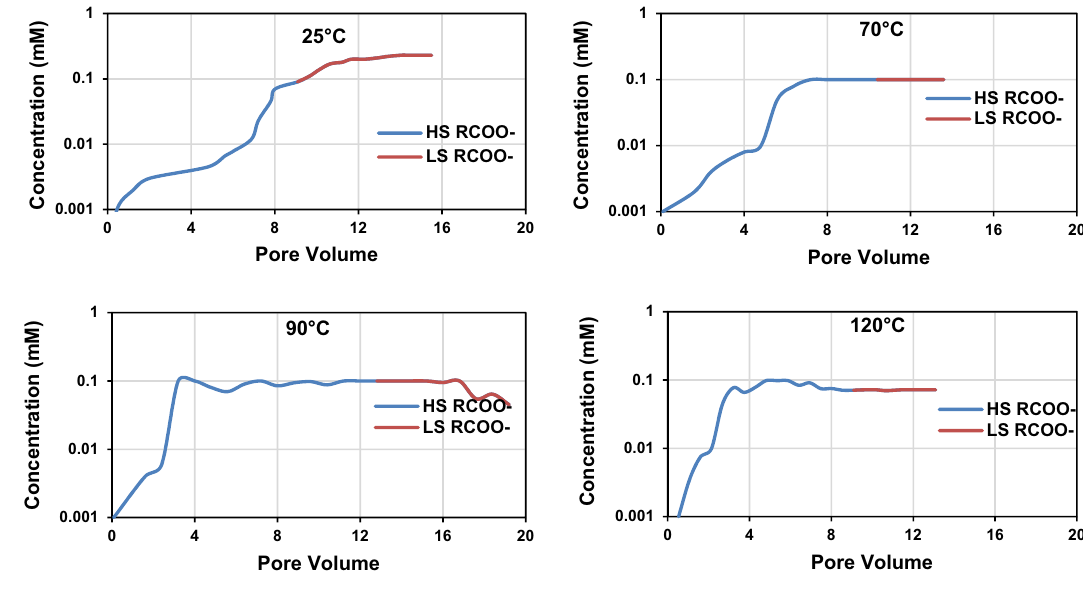
Fig. 12 Concentrations of RCOO − in first HS and LS water effluent for sandstone column#2 (sand + kaolinite), at 25, 70, 90, and 120